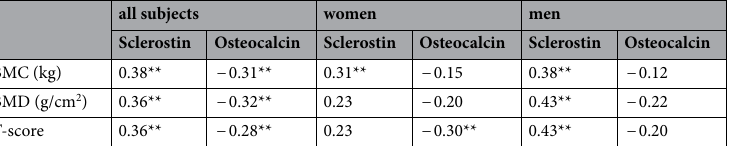
Table 4. Correlation coefficients between sclerostin or osteocalcin levels and bone parameters. Bone parameters were not adjusted for body weight. BMC, bone mineral content; BMD, bone mineral density. **p <